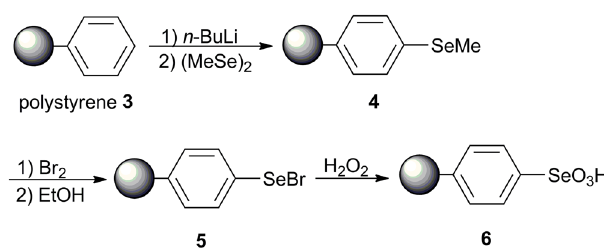
Figure 7. Preparation of the selenium-containing polymers 4–6